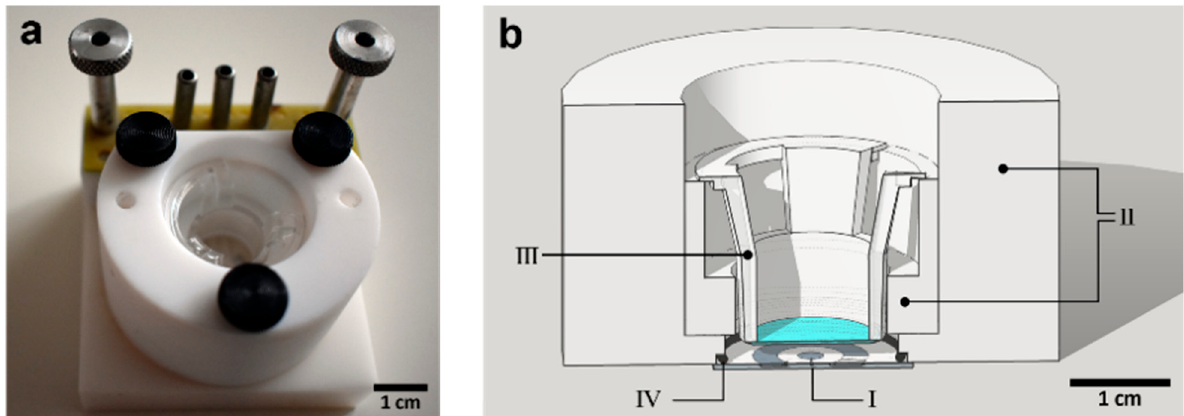
Figure 1. ( a ) Photograph of the chip- and Transwell insert-holder used in the experiment using RuOx electrode. Chip connection block equipped with pogo pins is used to connect the on-chip RuOx electrode to the impedance spectroscope. ( b ) Illustration of the cross-sectional view of the setup. Chip- and Transwell insert-holder (II) suspends the Transwell insert’s (III) membrane above the glass chip (I), with O-ring (IV) to seal the electrochemical cell. Cells were cultured on the top side of the membrane.